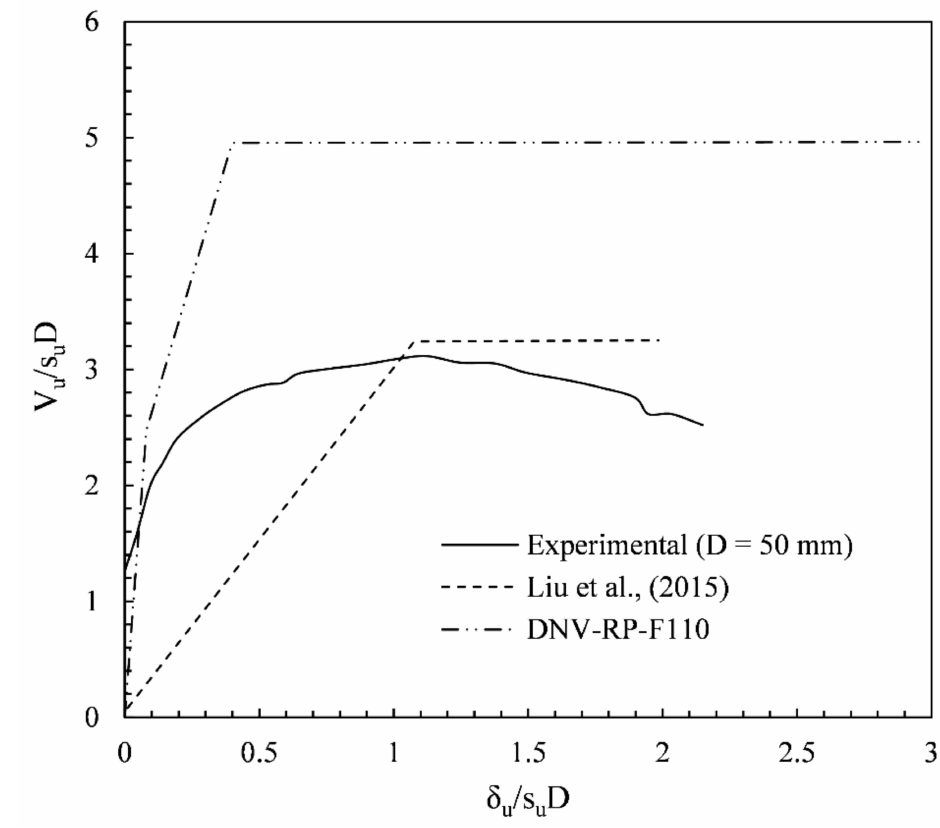
Figure 11. Comparison of uplift resistance vs uplift displacement behaviour for different methods of analysis